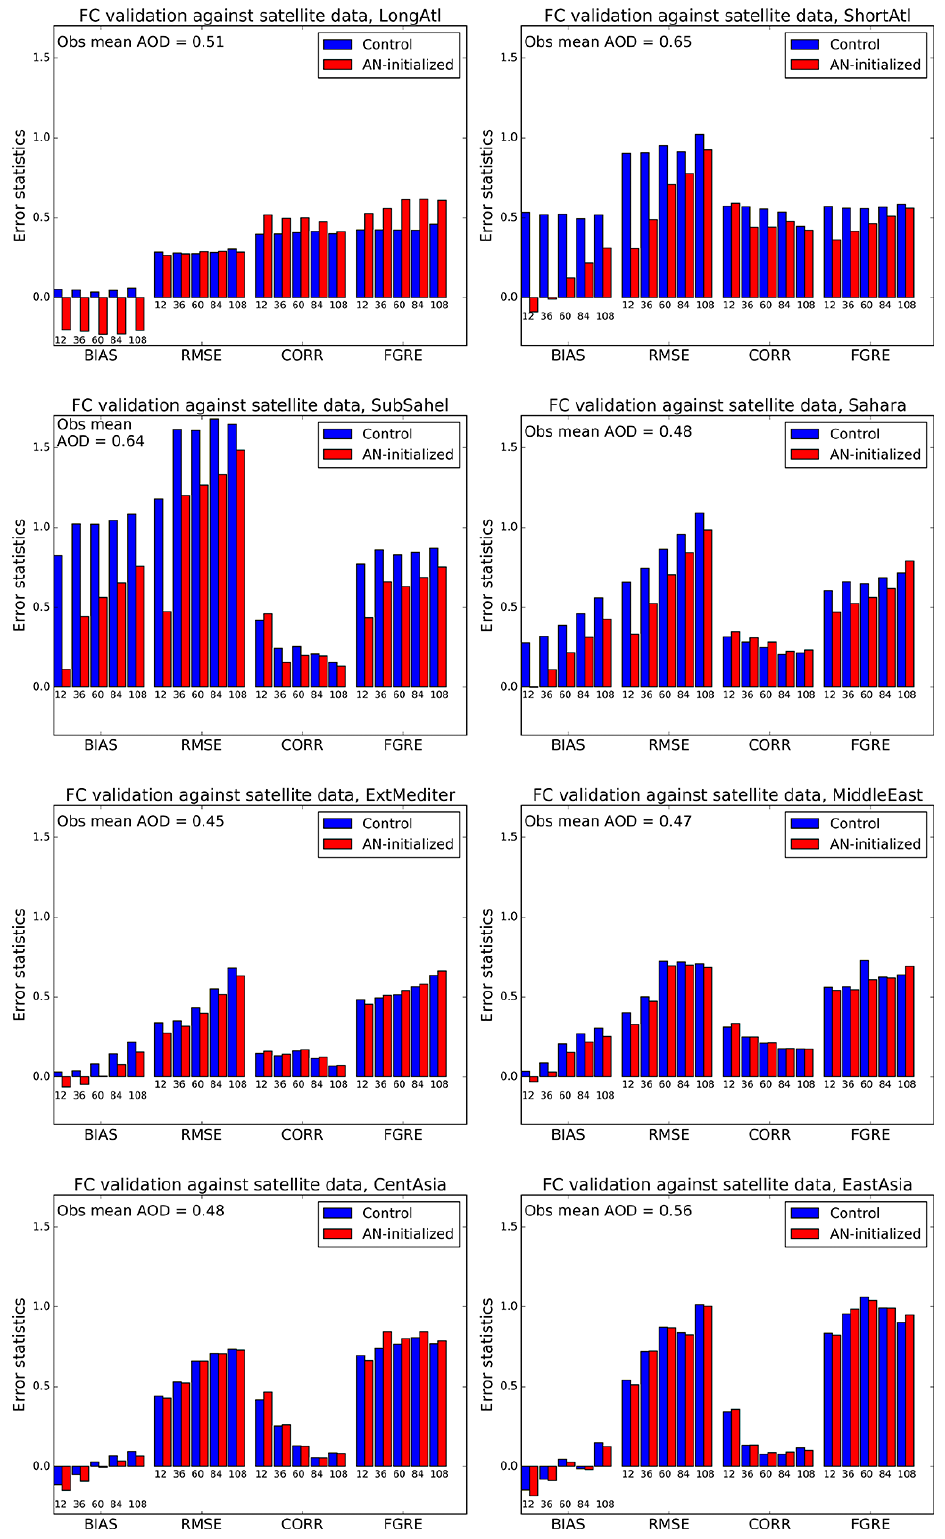
Figure 16. As the right panel of Fig. 15 but for the different regional domains of Fig. 5.